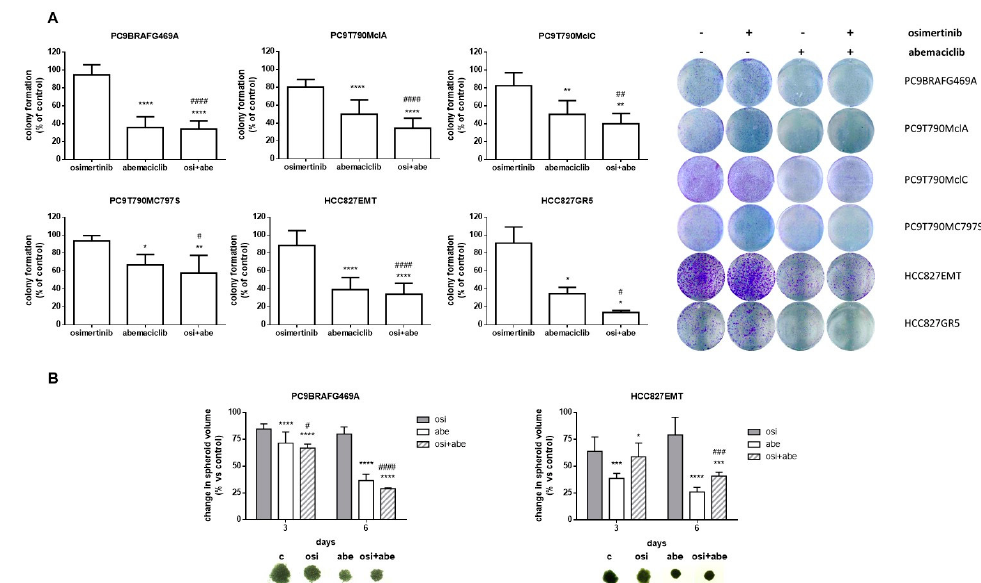
Figure 3. Effects of abemaciclib alone or combined with osimertinib on colony formation and 3-D cell growth. ( A ) The indicated osimertinib resistant cells were treated with 500 nM osimertinib, 500 nM abemaciclib or their combination and after 6 days colony formation was assessed as described in the Materials and Methods section. Representative images of crystal violet staining of colonies are shown. Data are the means ± SD of at least three independent experiments. ( B ) The growth of spheroids from PC9BRAFG469A and HCC827EMT cells was analyzed after 3 and 6 days of treatment with abemaciclib, osimertinib or both drugs. The data are expressed as percent of spheroid growth versus control. Representative images of spheroids after 6 days of culture are shown. Data are representative of two independent experiments (* p < 0.05, ** p < 0.01, *** p < 0.001, **** p < 0.0001 vs. control; # p < 0.05, ## p < 0.01, ### p < 0.001, #### p < 0.0001 vs. osimertinib).